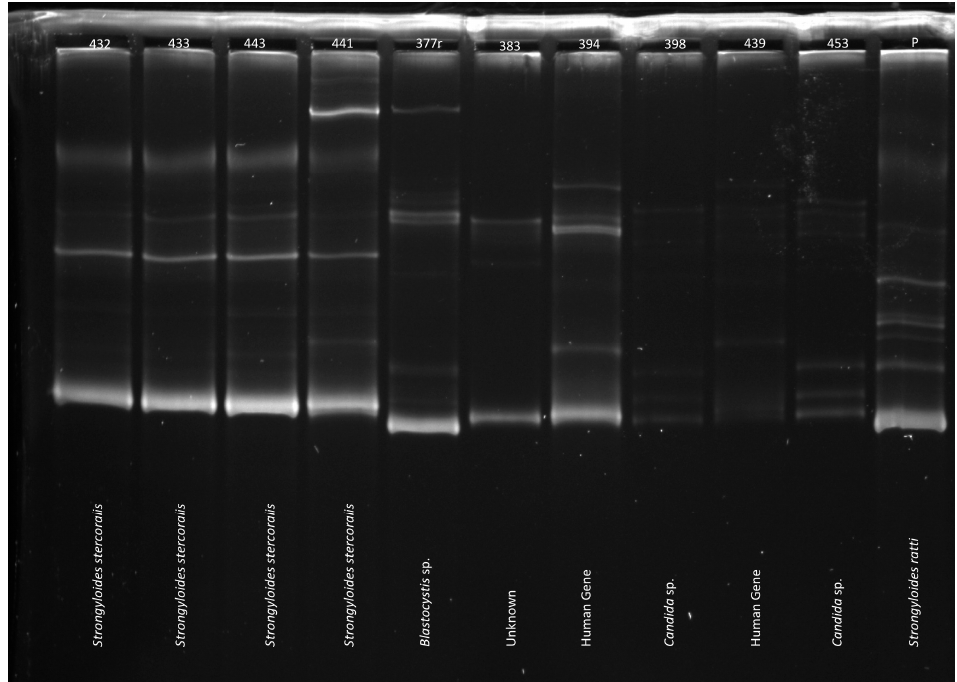
Figure 3. Sample single-strand conformational polymorphism (SSCP) gel, with text denoting results of sequencing. The banding profile for Strongyloides stercoralis is easily distinguishable from the other profiles which included Blastocystis sp., Candida sp. and human genes. Note prominent extra band in lane 441, which is most likely the result of conformers linked to sequence variability or background amplification.